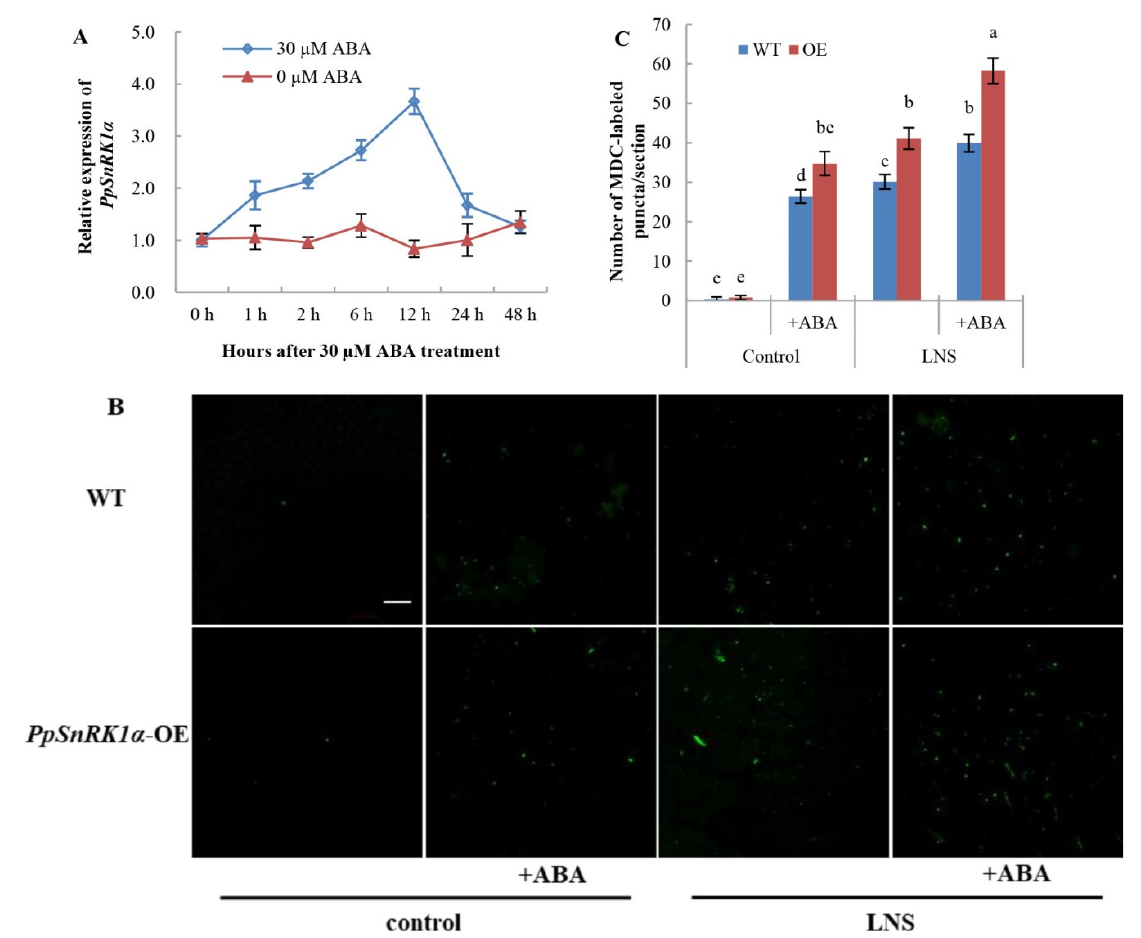
Figure 7. Effects of ABA on autophagy induction in tomato leaves. ( A ) Relative expression of PpSnRK1 α in OE leaves after 0 µ M and 30 µ M ABA treatment. ( B ) MDC-stained autophagosomes in the WT and OE leaves under LNS conditions. Autophagosomes by MDC staining are shown as green signals. Bars: 50 µ m. ( C ) The number of autophagosomes by MDC staining per image in ( B ) was quantified to calculate the autophagy activity. Data are expressed as the mean ± SD of seven biological replicates. Different lowercase letters indicate significant differences according to Duncan’s multiple range test ( p < 0.05).